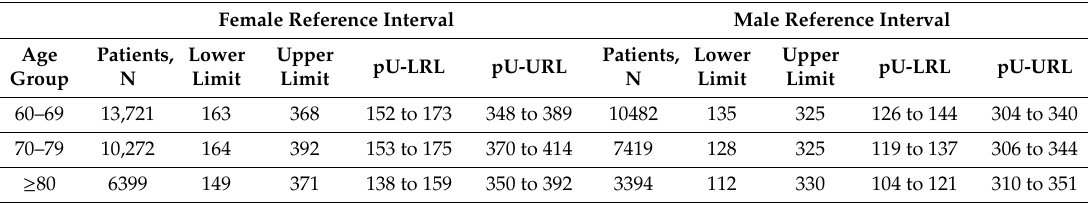
Table 3. Indirect reference intervals for platelet counts stratified according to age and sex. Last value of each patient was taken. pU-LRL and pU-LRL, permissible uncertainty of estimated lower and upper reference limit. Collapsed reference interval for females without age stratification is 157 pU-LRL (147, 167) to 365 pU-URL (345,